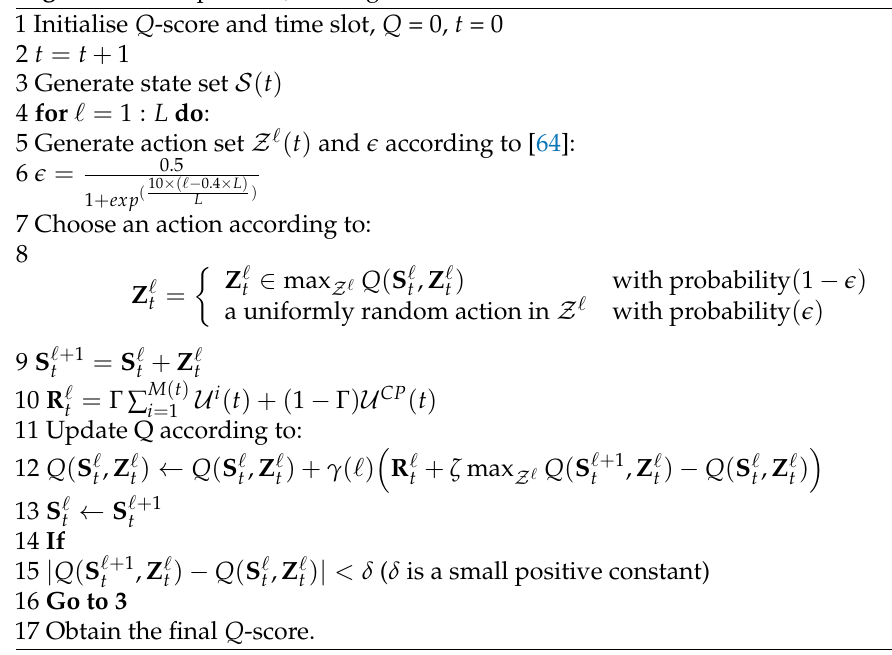
Algorithm 1 Proposed QLRA algorithm.